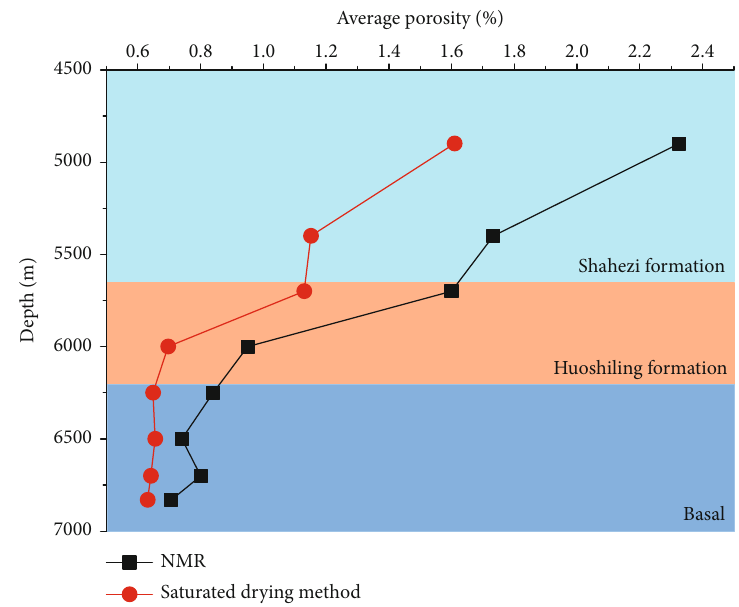
Figure 12: Comparison of porosity curves measured by NMR and saturated drying method.